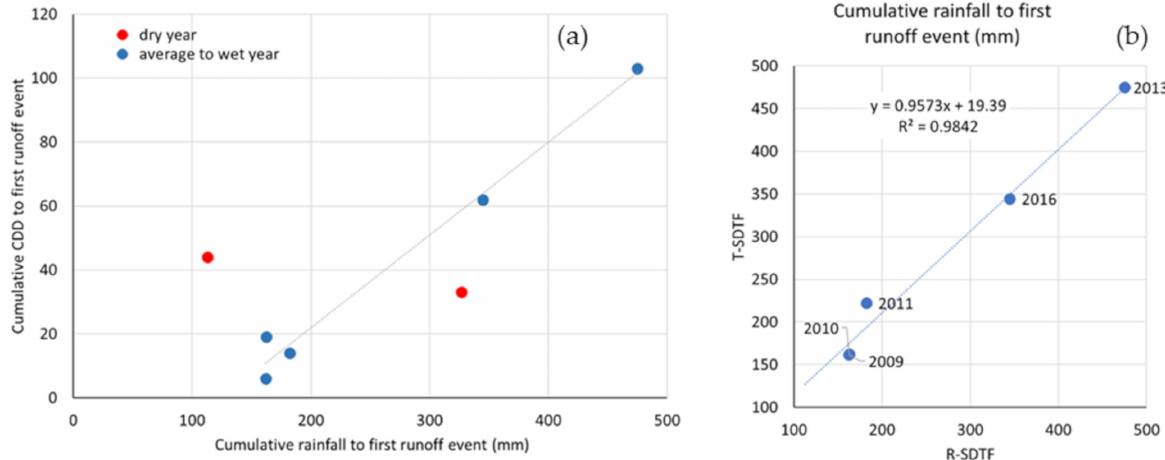
Figure 9. (a ) CDD vs. rainfall to first runoff event; ( b ) rainfall to first runoff event: regenerated vs. thinned vegetation